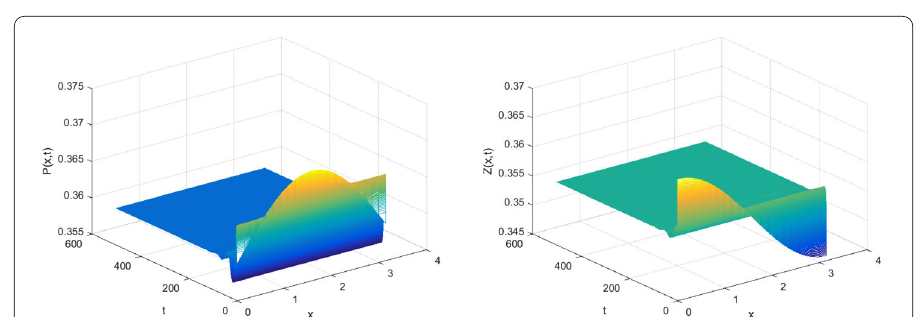
Figure 3 The numerical simulations of system (4.2) with E = 0.03 and initial condition (0.3,0.35)